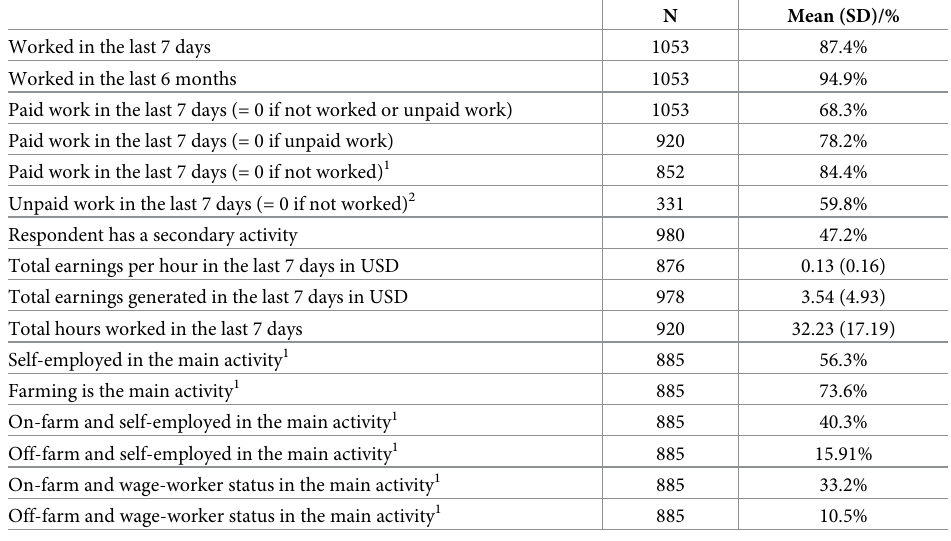
Table 4. Labor market outcomes of interest at baseline, full